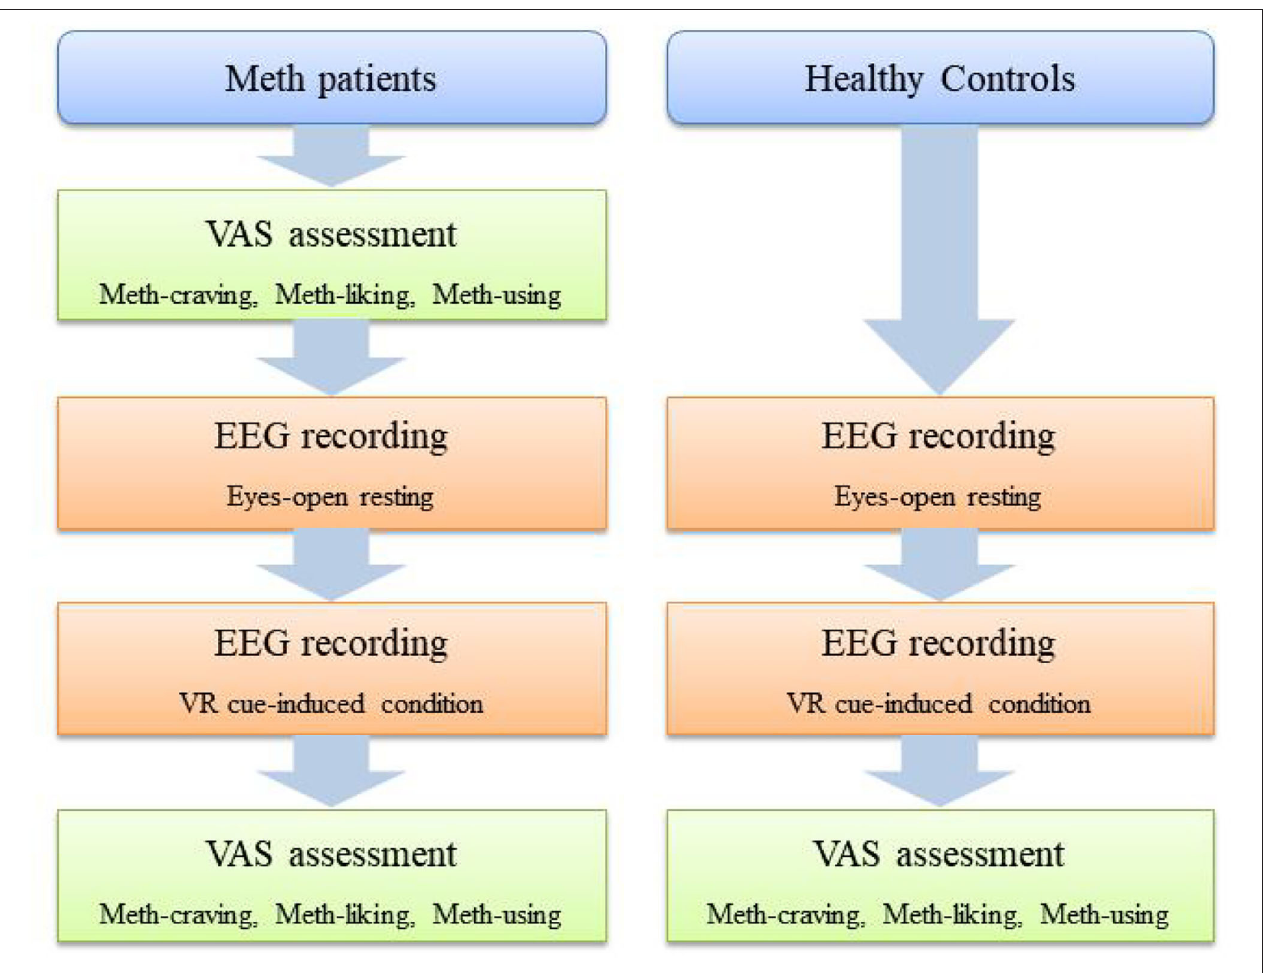
FIGURE 1 | Schematic diagram of assessment